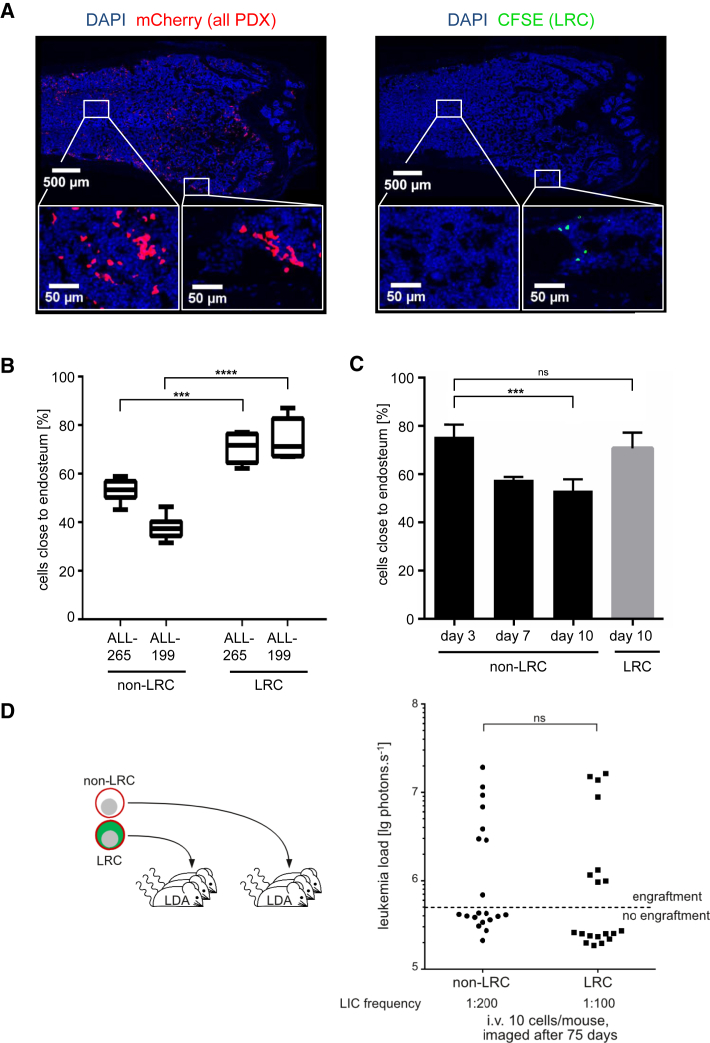
LRC Localize to the Endosteum, but Are Not Enriched for Stem Cells(A) Immunohistochemistry of consecutive mouse bone marrow femur sections 10 days after injection of CFSE-stained PDX ALL-265 cells; mCherry (red; left panel) indicates all PDX cells, CFSE (green; right panel) indicates LRC.(B) All sections from day 10 were quantified defining the endosteal region as less than 100 μm from bone matrix; shown is the median with upper/lower quartile and maximum/minimum of two to three sections from two femurs in two mice per data point; ∗∗∗p < 0.001, ∗∗∗∗p < 0.0001 by two-tailed unpaired t test.(C) Kinetic for ALL-265 as mean ± SE; ∗∗∗p < 0.01 by two-tailed unpaired t test.(D) Ten LRC or non-LRC were injected into each of 39 mice and engraftment was determined by in vivo imaging at day 75; each dot represents one mouse; dashed line represents detection threshold (5 × 105 photons s−1); ns: not significant as determined by two-tailed unpaired t test.See also Figure S3 and Table S3.